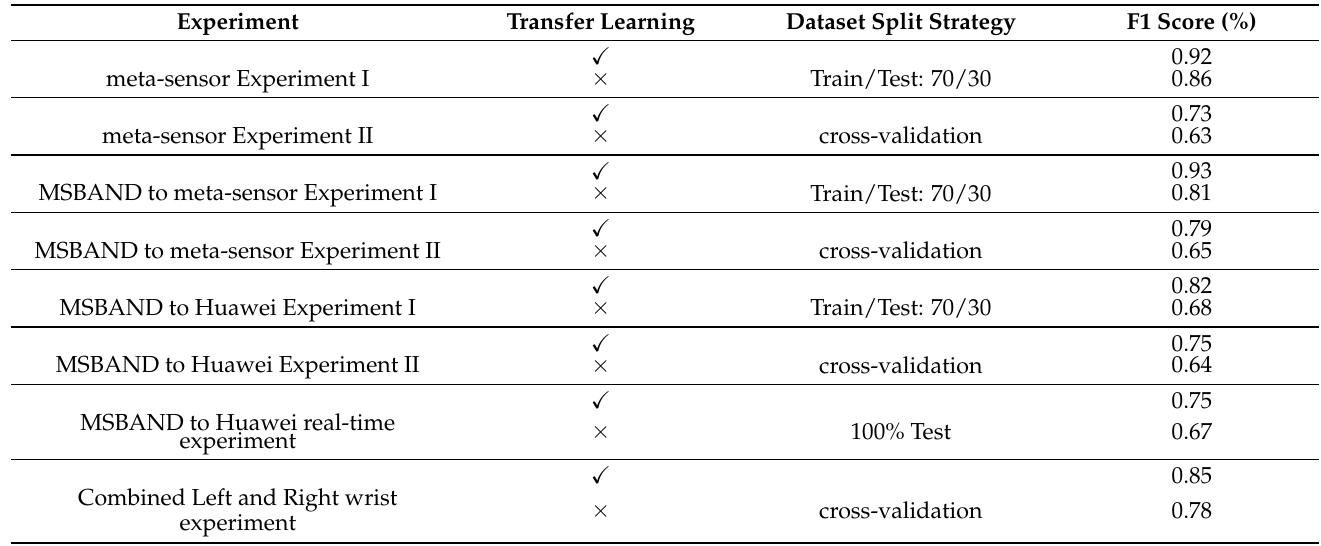
Figure 5. 70/30 Train/Test data split experiment for meta-sensor. Note that, TL stands for Transfer Learning , for prediction probabilities, x axis is the time, y axis is the prediction threshold, blue data is the real labels, red data is the prediction probabilities. Table 5. Summarization results of F1 score for all experiments. Train/Test denotes the train/test dataset split ratio. A check mark (cid:88) represents the transfer learning strategy applied and a × denotes the transfer learning is not